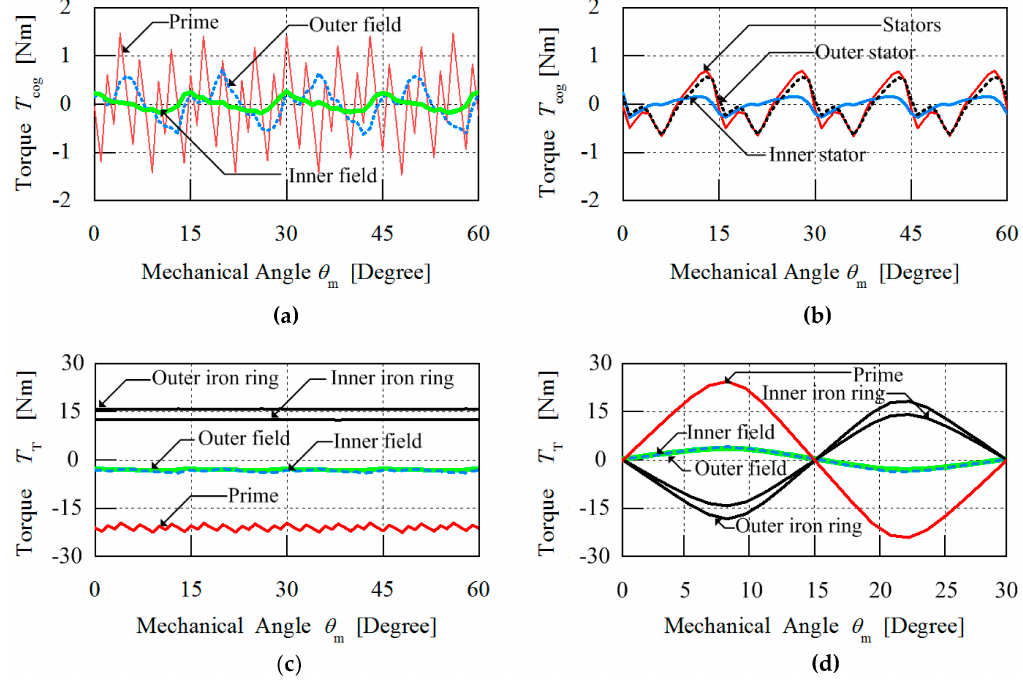
Figure 13. The cogging torque and transmission torque characteristics of the DS-MGM: ( a ) Cogging torque generated by iron rings of the magnetic gear; ( b ) Cogging torque generated by stator slots of the machine; ( c ) Transmission torque of the magnetic gear; ( d ) Pull-out torque angle curves. Table 4. Cogging torque characteristics of the magnetic gear.